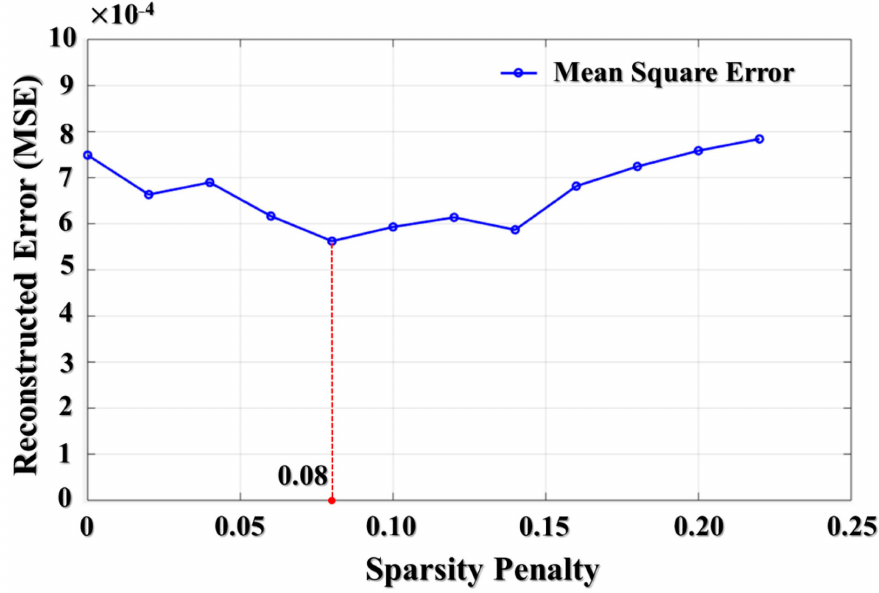
Figure 10. The relation graph between the sparsity term and the reconstruction